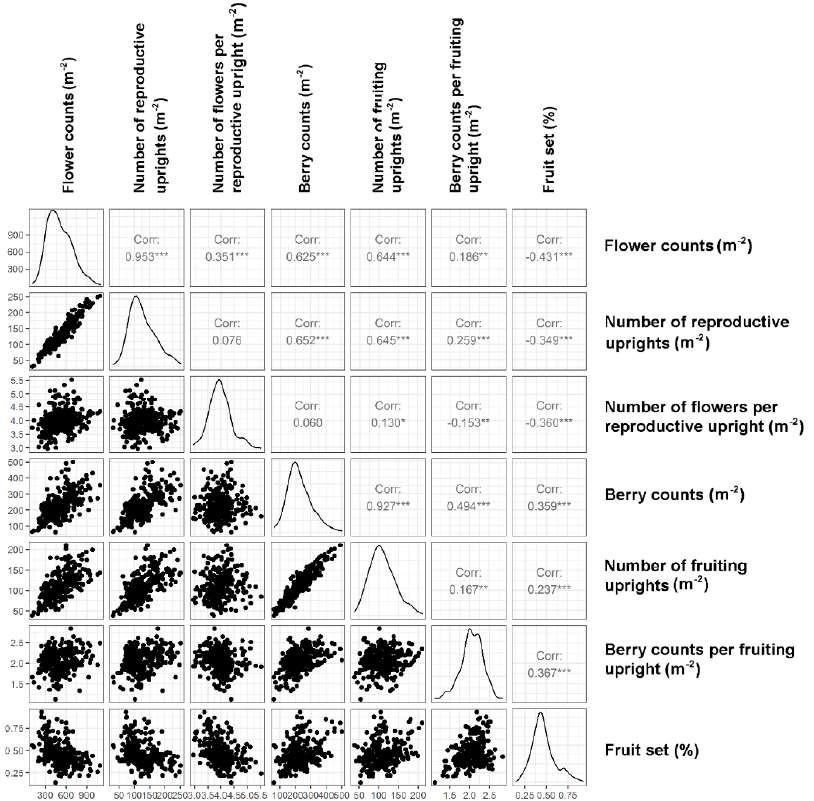
Figure 5. Matrix of correlations among yield components in the cranberry data set. The diagonal shows graphs of the original data after adjusting for all other variables. Upper: Pearson correlation. ** Correlation significant at the 0.05 level; *** Correlation significant at the 0.01 level.